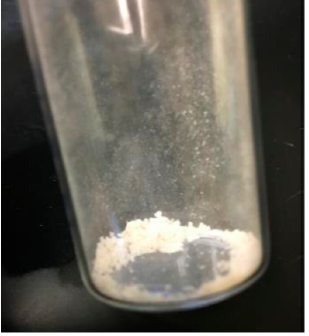
Figure 2. White powder collected after the workup.